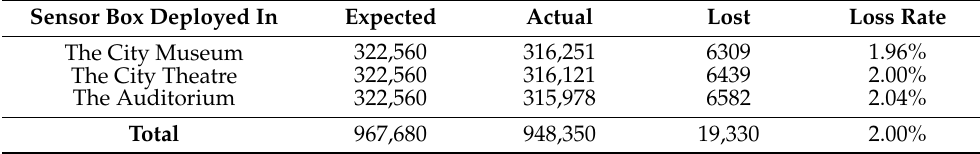
Table 1. The loss rate of data samples per sensor box and the average loss rate of data samples for three sensor